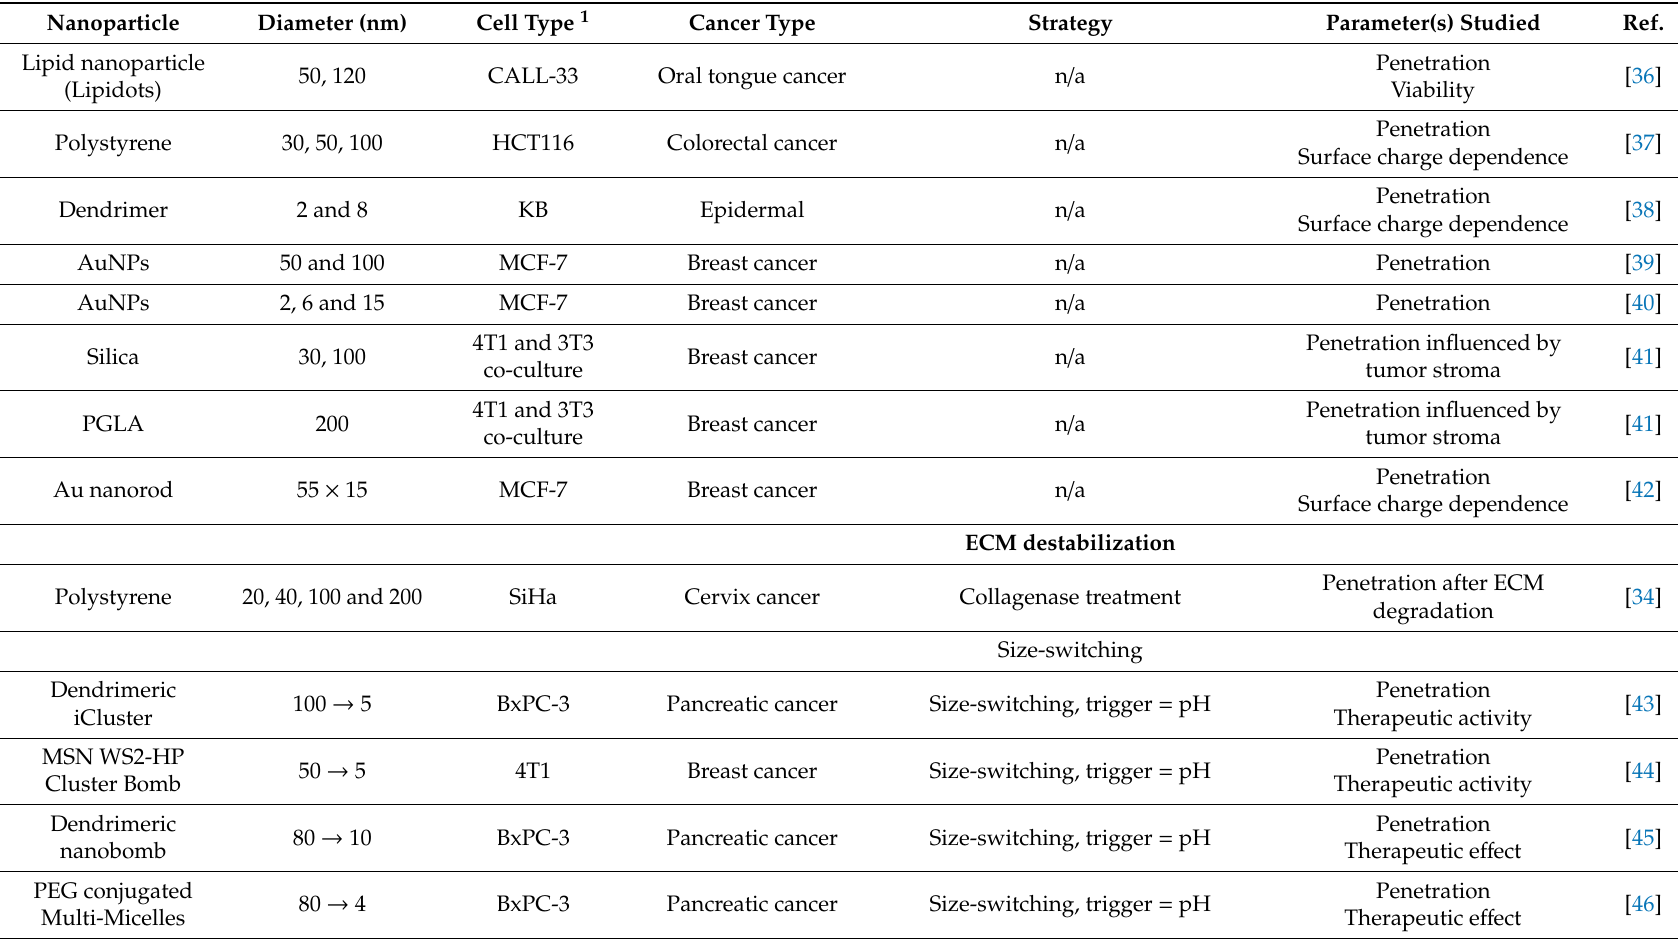
Table 1. Overview of nanoparticle studies using the multicellular tumor spheroid (MCTS)